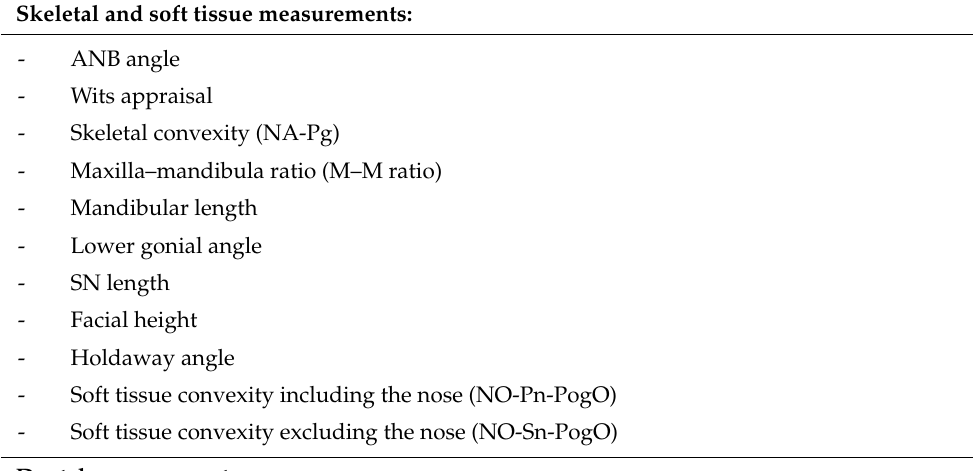
Table 1. Cephalometric values used to identify skeletal borderline